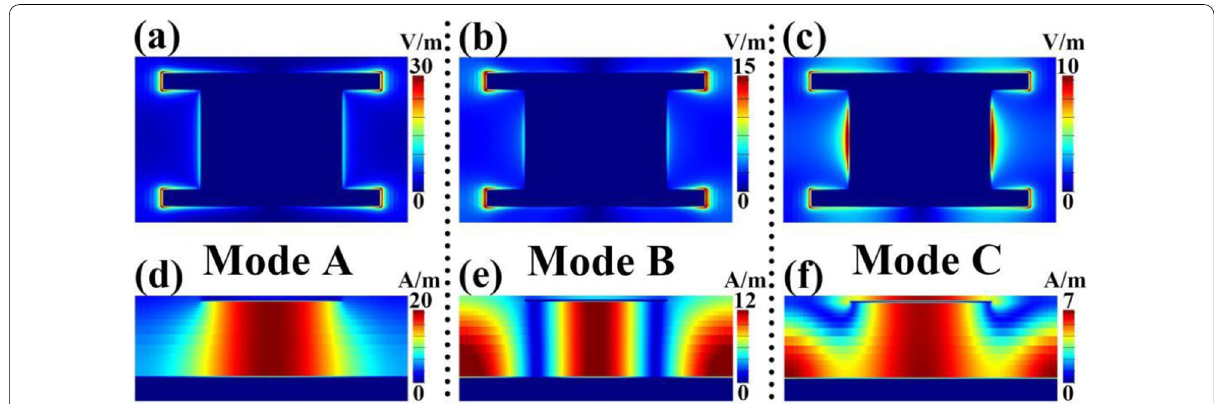
Fig. 3 a – c provide the | E | field distributions of frequency points A, B, and C of the analogy I‑typed resonator, respectively; d , e , and f provide the | Hy | field distributions of frequency points A, B, and C of the analogy I‑typed resonator,